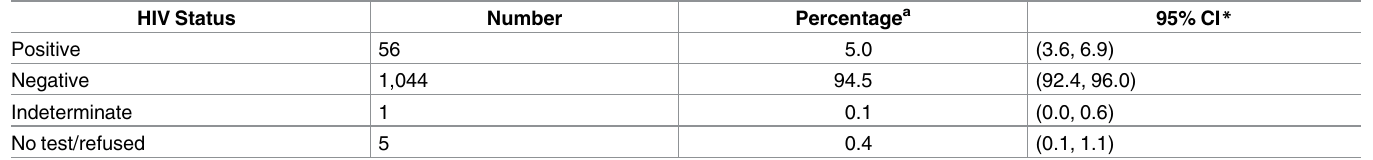
Table 2. HIV prevalence among SPLA